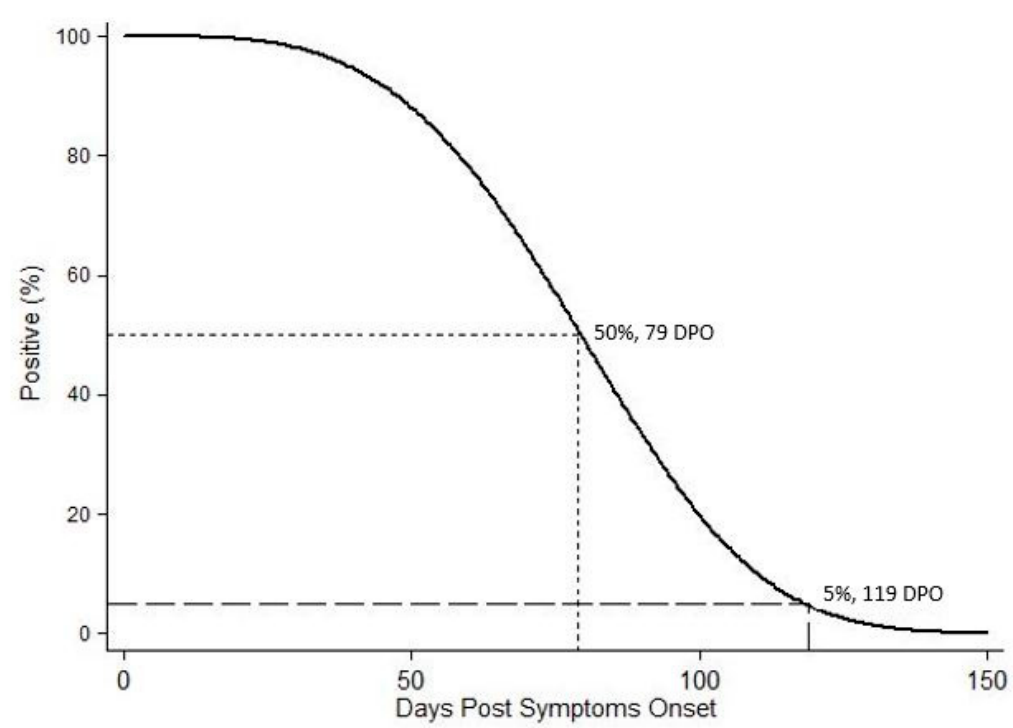
Figure 2. Weibull distribution model of the time to loss of WNV RNA detection in whole blood specimens.